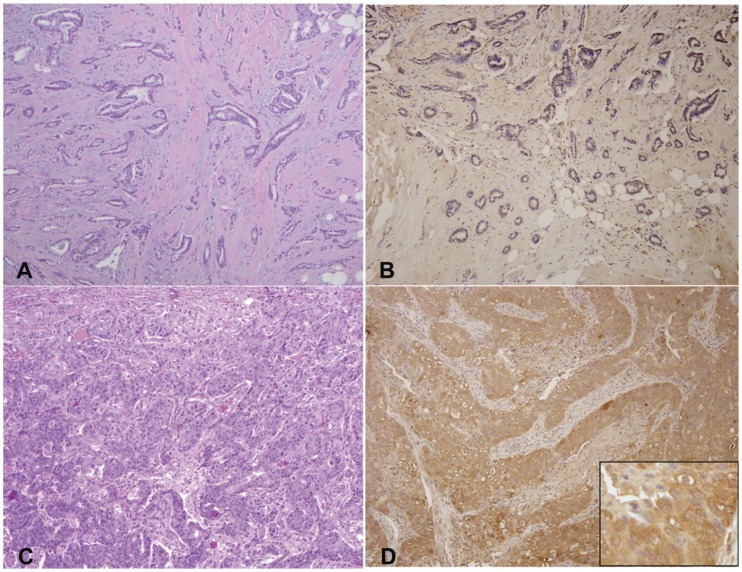
WAVE3 protein staining levels are increased in the high grade BC.Representative WAVE3 IHC micrographs with matching hematoxylin & eosin of BC tumors. (A & B) mSBR grade 1 with negative staining and (C &D) mSBR grade 3 with diffusely strongly positive (score 300) staining. WAVE3 staining is shown as brown color in panels B and D. The final WAVE3 score is determined as product of the staining intensity (0, 1, 2 or 3) times the percent of tumor cells showing WAVE3 staining (0% to 100%). Therefore the final WAVE3 score can vary from 0: no cells are being satined for WAVE3, to 300, where 100% of tumor cells show strong WAVE3 staining. Insert figure in panel D shows cytoplasmic expression of WAVE3 (100x).